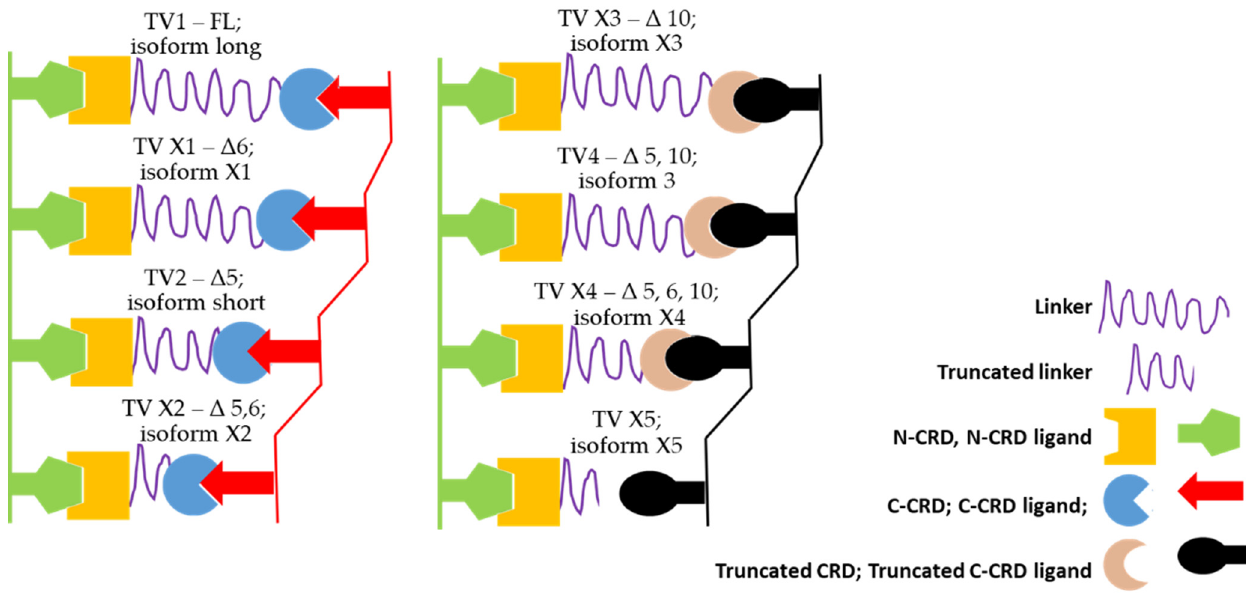
Figure 10. Hypothesis of galectin-9 truncation in modulating its function. Truncating the linker peptide by splicing exons 5 and/or 6 can modulate the distance at which the divalent lectin is able to link two specific sites. C-CRD truncation (splicing of exon 10) may alter the specificity of oligosugars. The protein variant X5 appears to be a monovalent lectin and can either label sites with specific ligands for further interactions or, conversely, block them before they can interact with divalent lectins, thereby preventing efficient cross-linking.